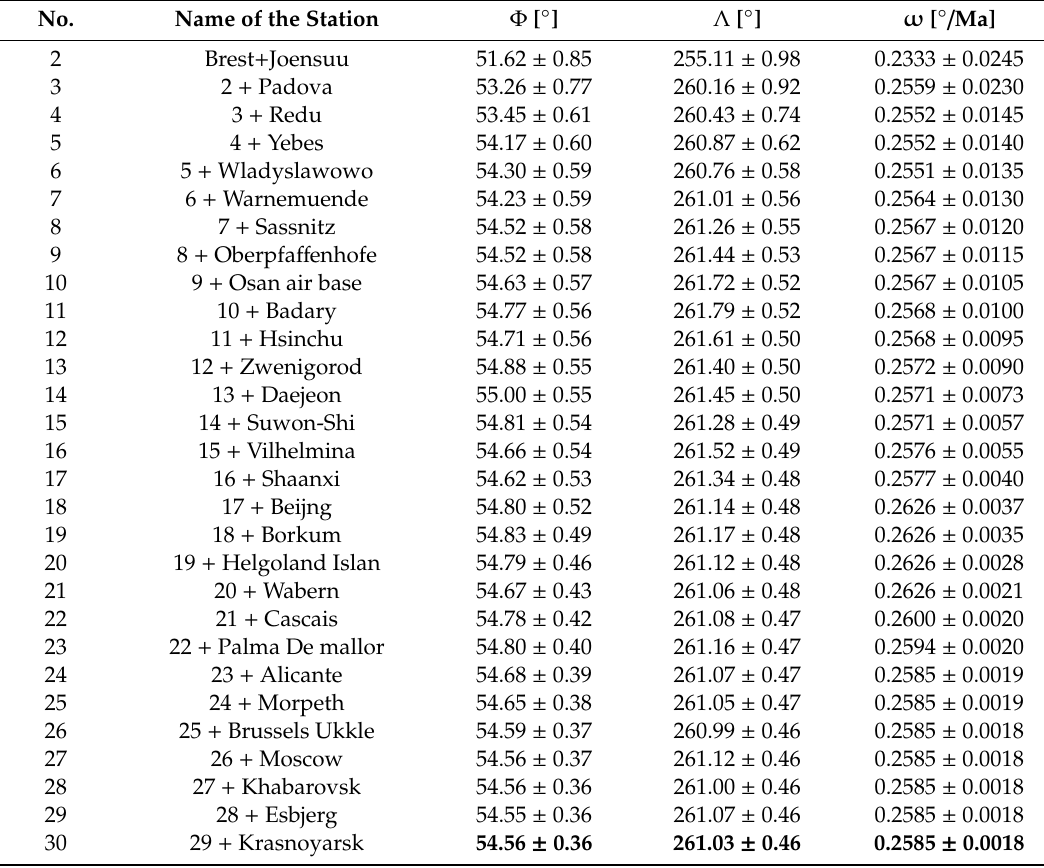
Table A3. Computed plate motion parameters, and their errors, of the Eurasian plate for the GNSS network using the sequential method. Scenario 3 of the